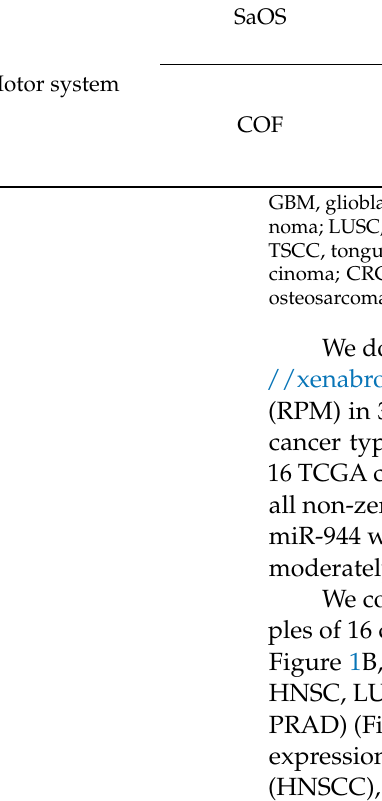
Figure 1. Pan-cancer analysis of miR-944 based on TCGA database. ( A ) Histogram of median quan- tile expression of miR-944 in non-tumor and tumor groups in the TCGA database. The blue font indicates that miR-944 is significantly low expressed in this cancer type; the red font indicates that miR-944 is significantly highly expressed in this cancer type; ( B ) comparison of miR-944 expression levels between non-tumor and tumor groups in the TCGA database. *** means p < 0.0000625; ** means p < 0.000625; * means p < 0.003125; ns means no significant difference; ( C ) overview of SNVs of TP63; ( D ) mutation types in TP63 protein domains in various cancers; ( E ) differences in the ex- pression level of miR-944 between the TP63 mutant group (Mut) and the wild group (WT). Ns